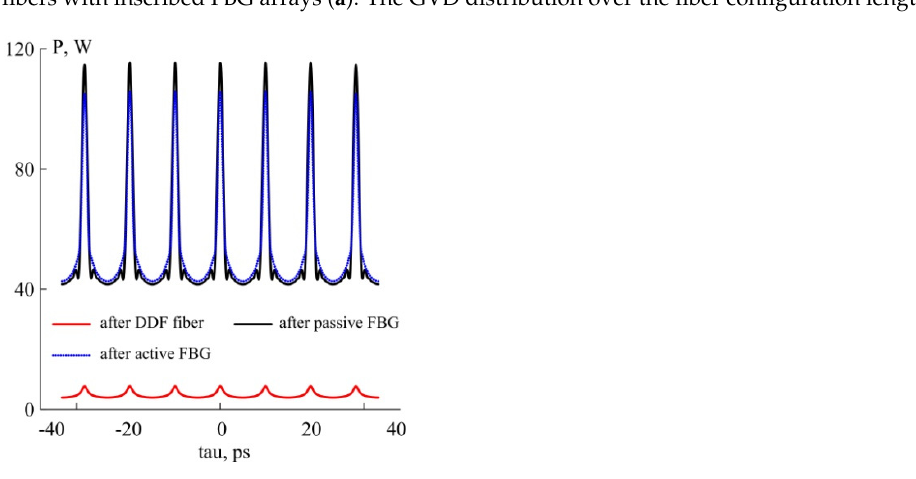
Figure 6. Generation of FM pulse trains in the cascade of active and passive fibers with the inscribed FBG arrays.